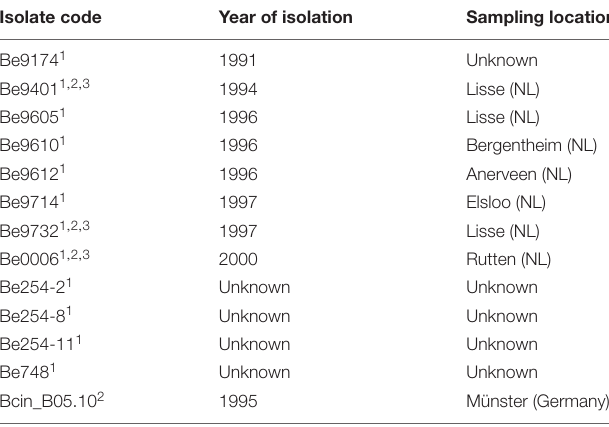
TABLE 2 | Botrytis isolates used in this